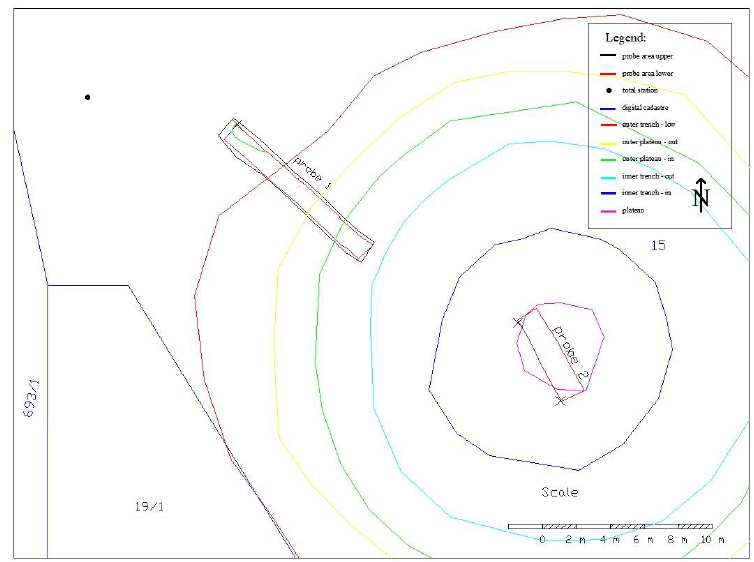
Figure 6. Geodetic plan of excavations.